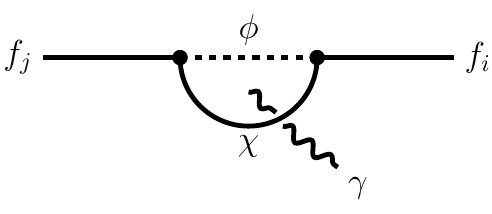
Figure 8 . The diagram generating the dipole operator of eq. (2.3) from a generic UV theory with new heavy scalars ( φ ) and fermions ( χ